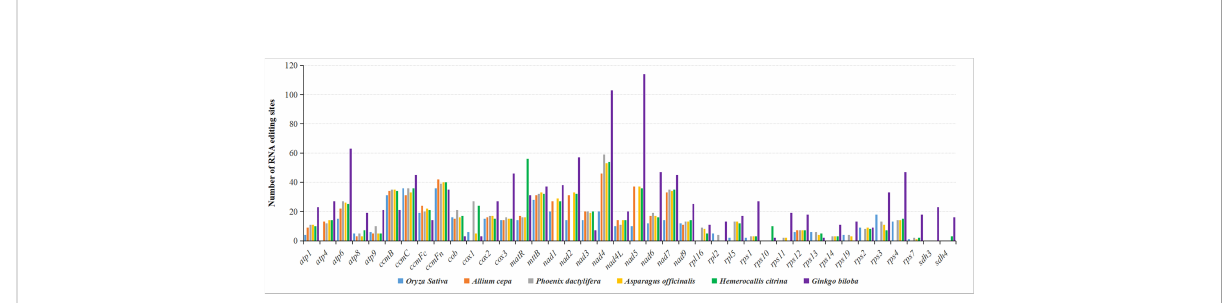
FIGURE 5 Prediction of RNA editing sites in the H. citrina mitogenome and fi ve other